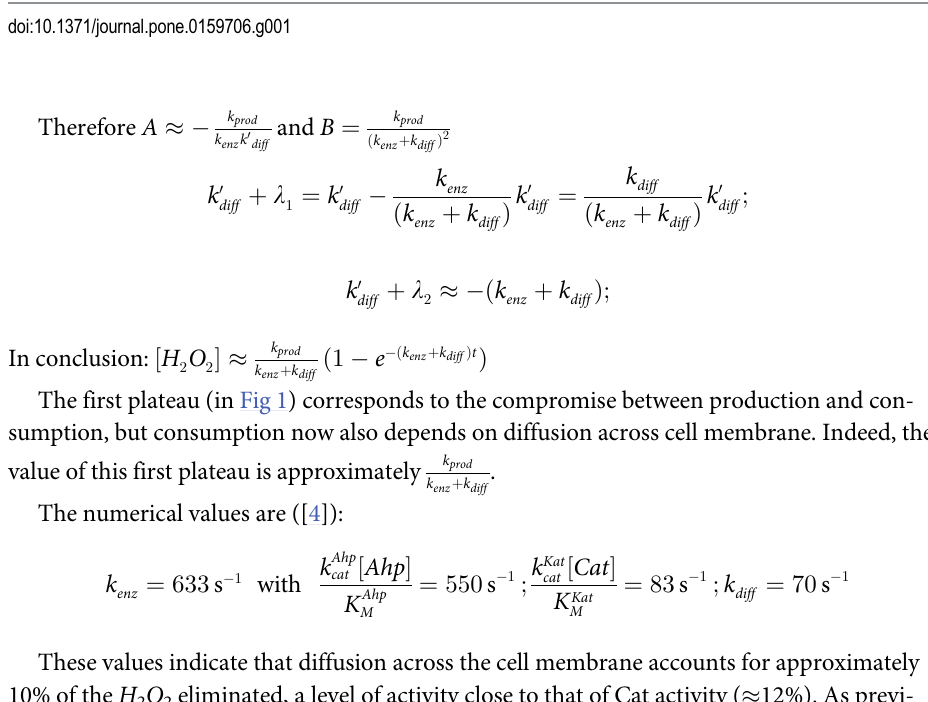
Fig 1. Changes in internal H 2 O 2 concentration in the wild-type strain with 10 7 cells ml − 1 . (+) corresponds to the analytical solution of internal H 2 O 2 evolution according to the simplified system and ( (cid:10) )) corresponds to the whole model solved with numerical